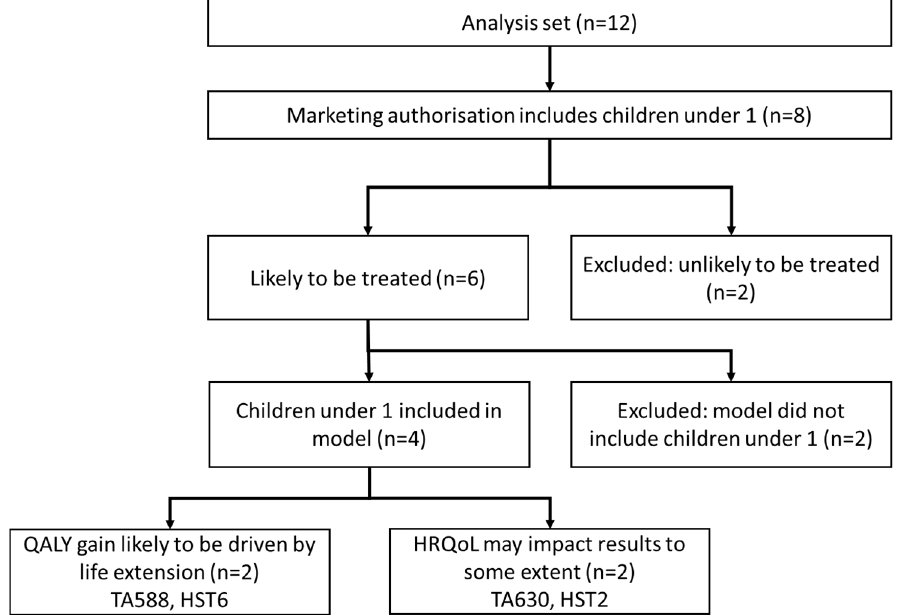
Figure 4. NICE appraisals including children under 1 as part of the